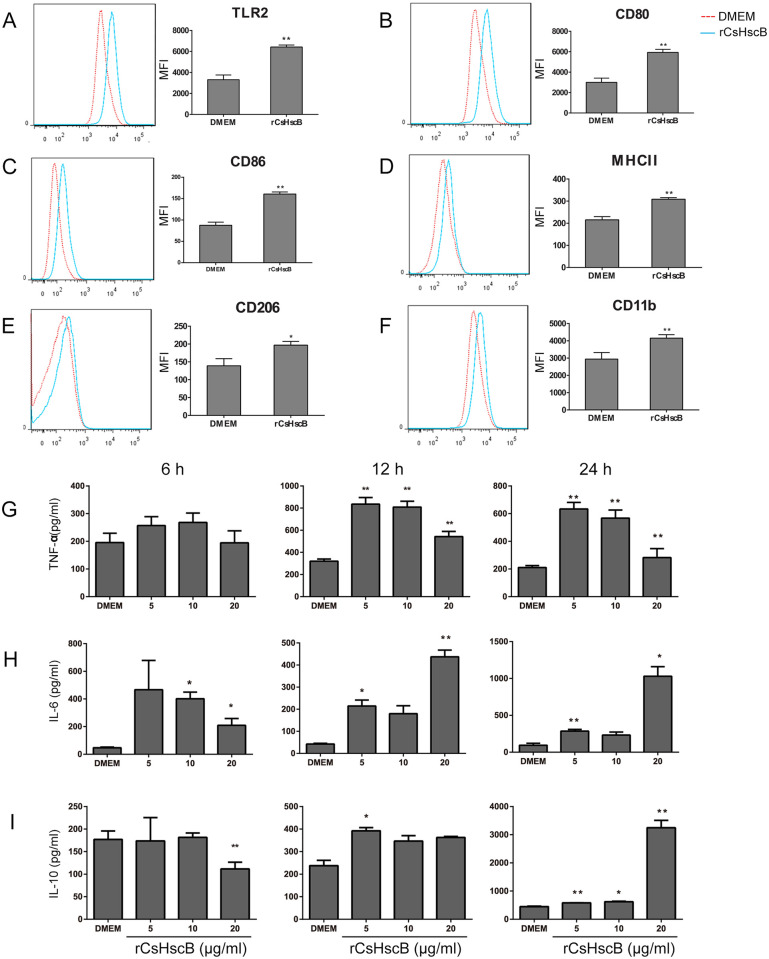
rCsHscB induces the activation of macrophage and cytokine production.(A~F) rCsHscB increased the expression of macrophage activation markers by flow cytometry. (G~I) productions of TNF-α (G), IL-6 (H), and IL-10 (I) were assayed for ELISA in the macrophage stimulated by indicated concentrations of rCsHscB for different time courses. Quantitative data are the mean±SE of three independent experiments, and all data shown are representative of at least three independent experiments (n = 4~5). *P< 0.05, **P< 0.01, and ***P< 0.001, stimulated cells versus those cultured in medium alone.